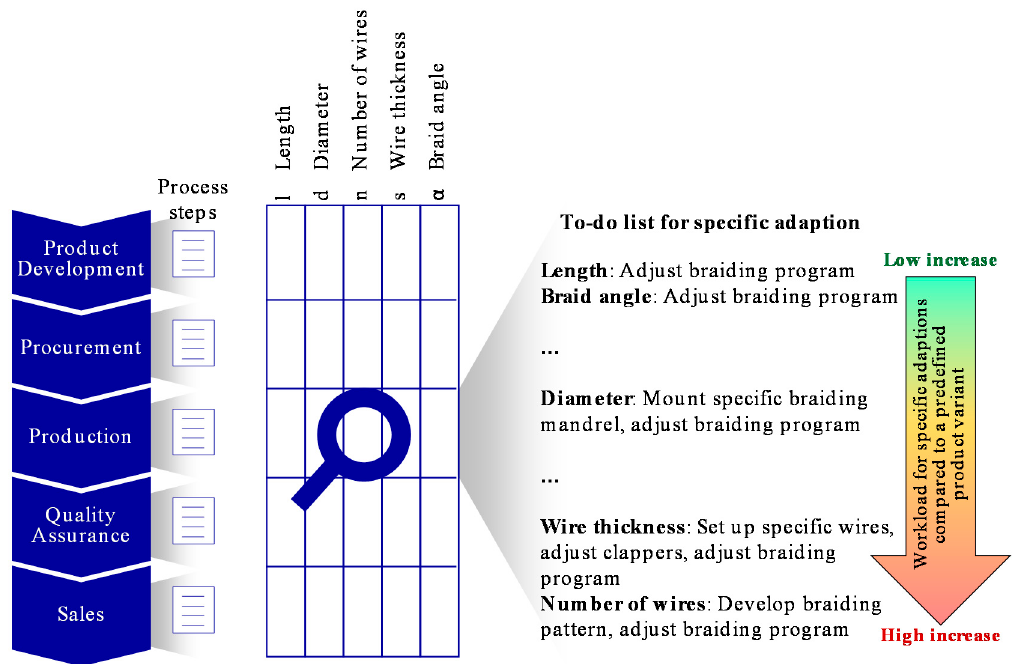
Figure 12. Analysis of the internal effects of individualization based on an examination of the to-do list for an individual design of the product characteristic in the different phases of the product lifecycle .